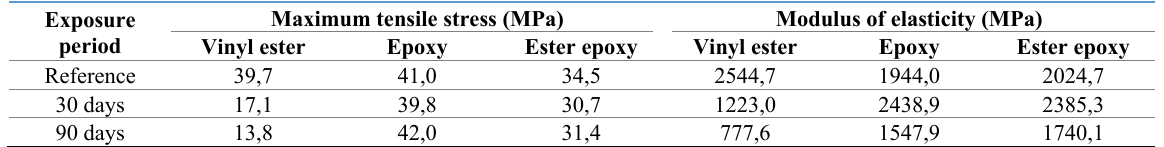
Table 1 Mechanical properties of resins after exposure to UV radiation